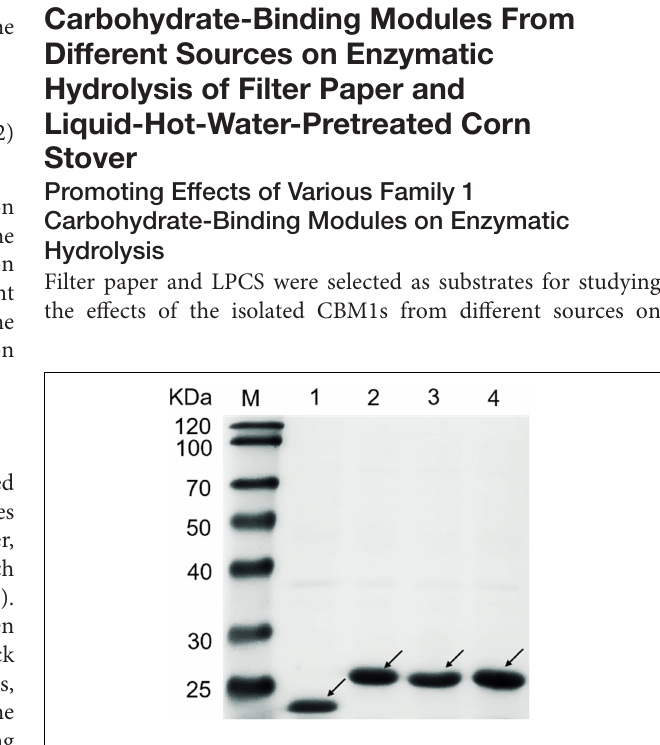
FIGURE 1 | SDS–PAGE analysis of TrCBM, PoCBM, PfCBM, and Tag protein. Lane M, protein marker; Lane 1, Tag; Lane 2, TrCBM; Lane 3, PoCBM; Lane 4,